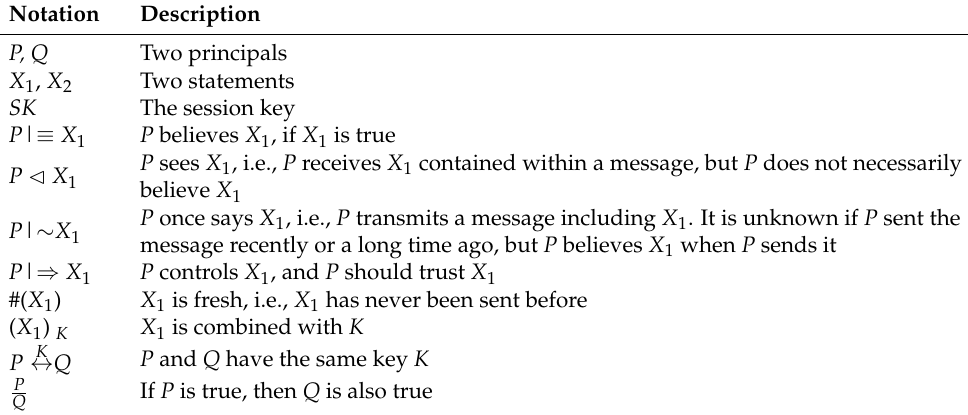
Table 3. The notations of BAN